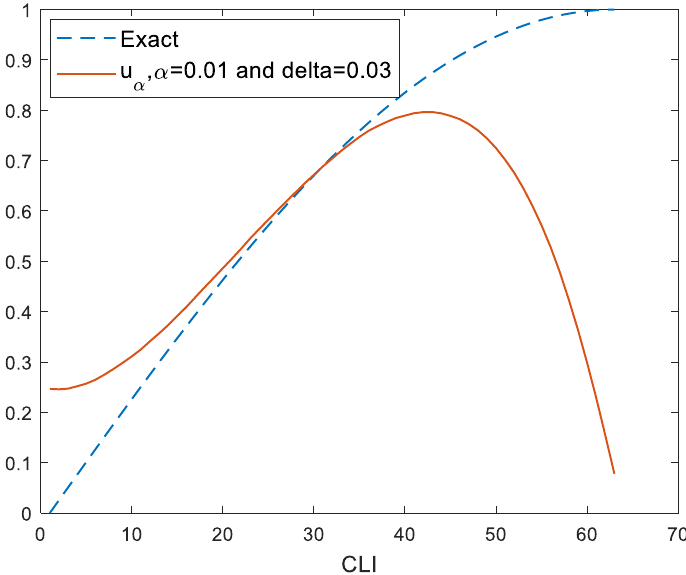
Figure 2. Approximation solution by CLI. In Figure 3, the iterations increased to 10,000.